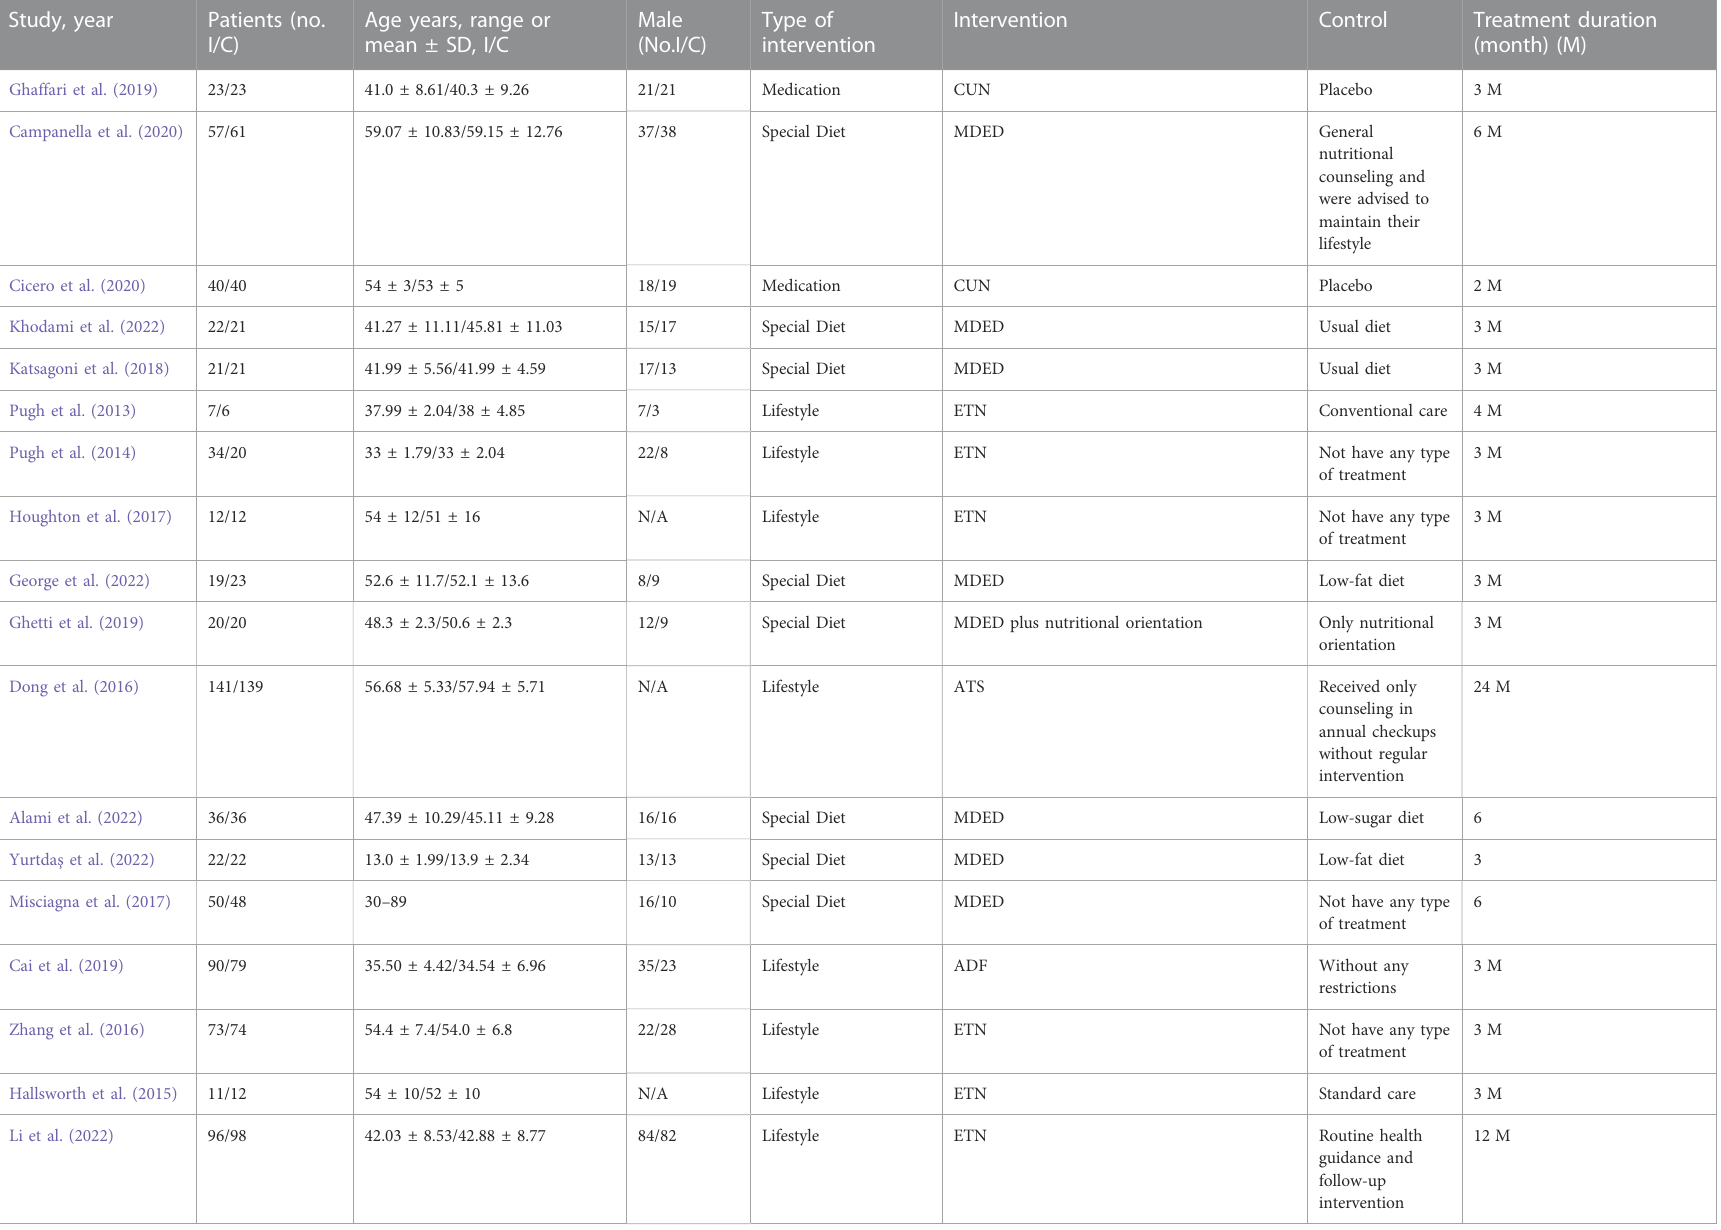
TABLE 1 De fi nitions of terms in included